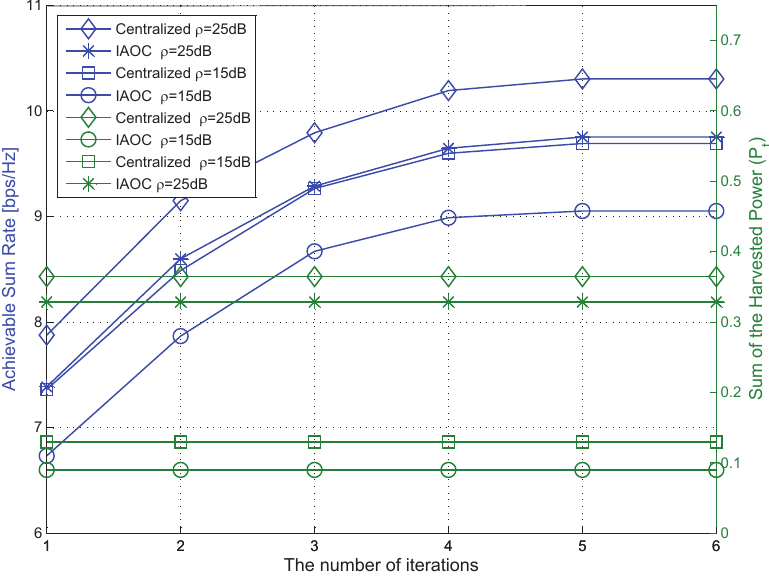
Figure 2. Convergence property of IAOC. K = 3, N r = 3, N t = 2, S = 2, α = 0.9, N =